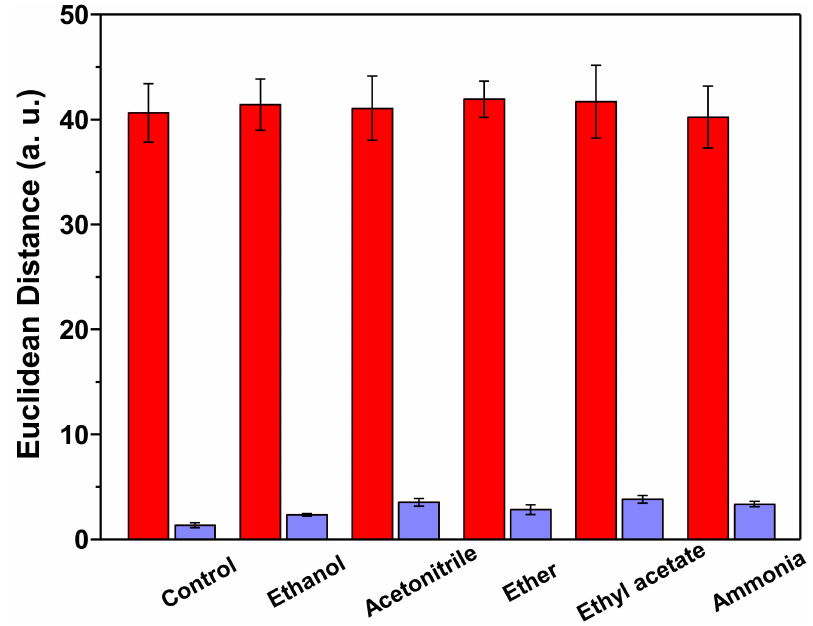
Figure 8. Sensor responses to 1 ppm cyclohexanone with (red bars) or without (blue bars) the presence of interferents, all at 1 ppm. Error bars showing the standard deviation among three replicates of each analyte are